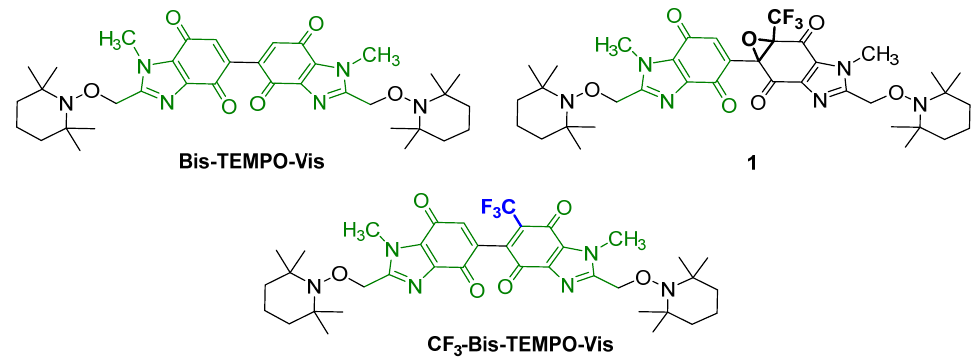
Figure 1. Bis-alkoxyamines [3] and new CF 3 -Bis-TEMPO-Vis .